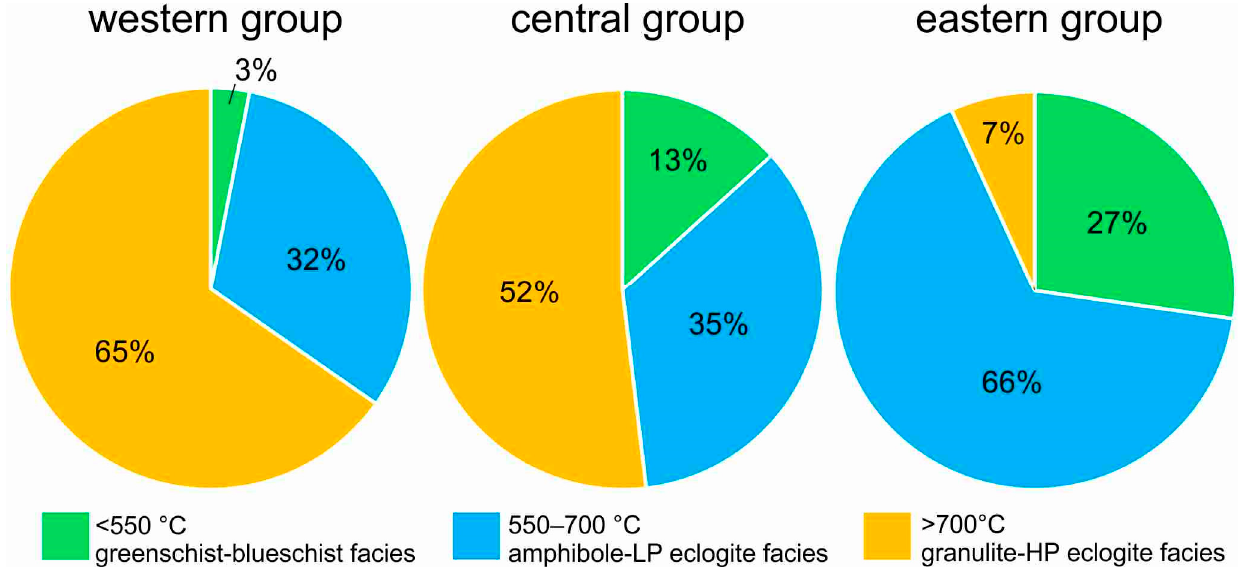
Figure 8. Pie chart of relative abundances of rutiles from different metamorphic facies in the western, central, and eastern groups.